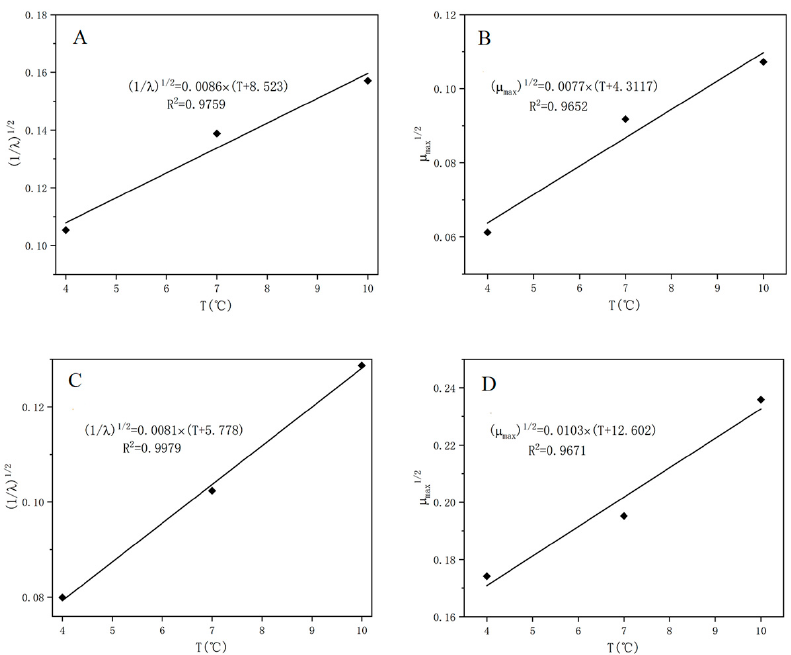
Figure 5. The secondary growth model of S. putrefaciens based on the response values of selected sensors P30/2. ( A , B ): Square root model based on Gompertz model; ( C , D ): Square root model based on logistic model.